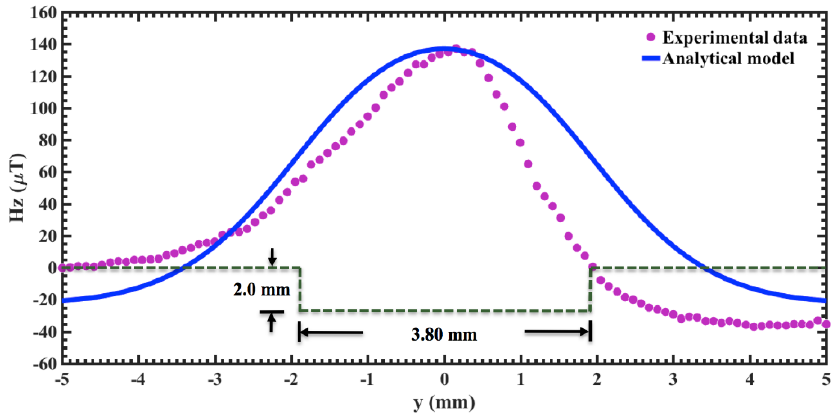
Figure 7. Tangential MMM signal of the rectangular defect S2 of the ASTM A-36 steel pipe.